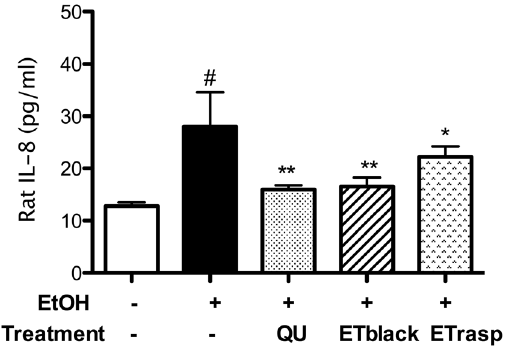
Figure 9. Effect of ETs from blackberry and raspberry on CINC- 1 (IL-8 homologue) exvivo . CINC-1 release was evaluated using GRO/ CINC-1 (rat) EIA kit which uses a polyclonal antibody to rat GRO/CINC-1 labelled with the enzyme horseradish peroxidase. After a short incubation (10 minutes) the enzyme reaction was followed by spectroscopy (signal read 450 nm, 0.1 s). The concentration of rat GRO/CINC-1 in the samples was determined by interpolation with a GRO/CINC-1 standard curve. The results (mean 6 se, n=6) are expressed as pg of CINC-1 per mL of sample. * p , 0.05, ** p , 0.01.